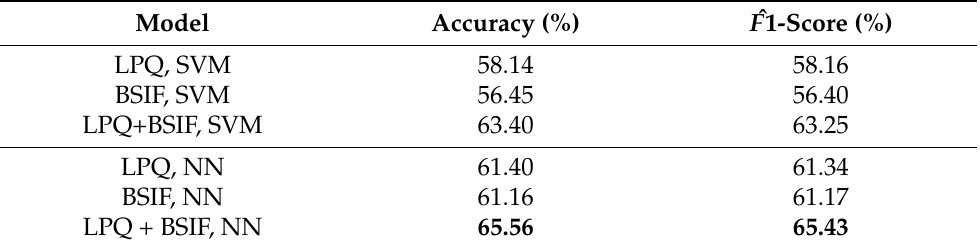
Table 3. The results of LBQ and BSIF descriptors and their combination using SVM and NN classifiers on CRC-TP